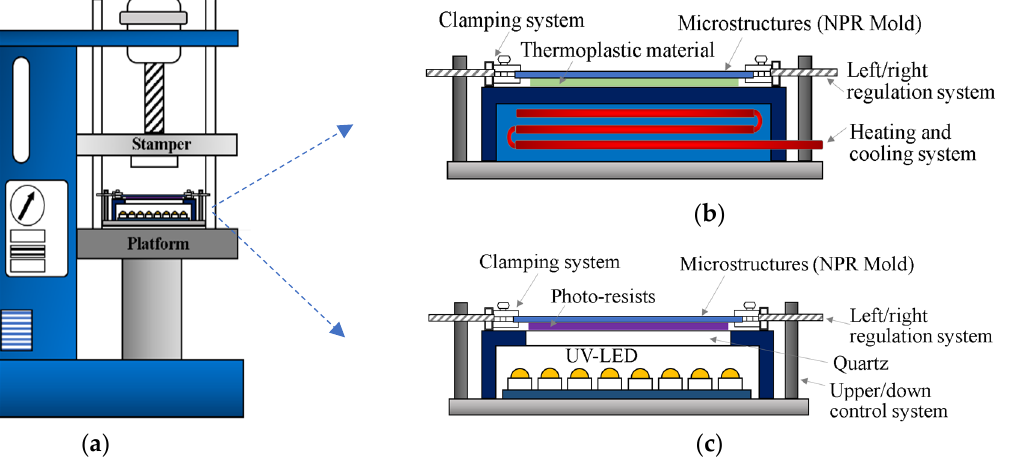
Figure 5. P2P-forming system for the uniaxial NPR microstructure replication ( a ) embossing system and mold system; ( b ) uniaxial NPR microstructure hot-embossing replication system; and ( c ) uniaxial NPR microstructure UV-curing replica- tion system.